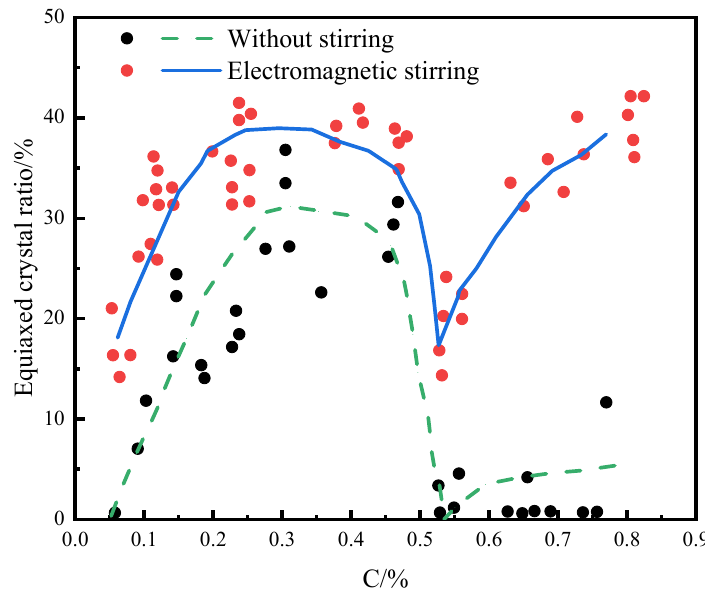
Figure 11. Effect of carbon content on the equiaxed grain ratio of billets [27].